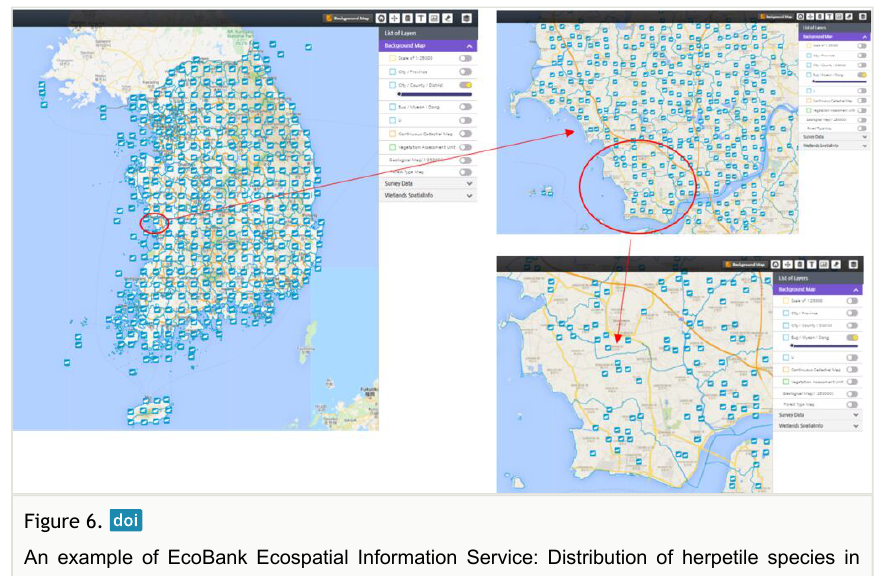
An example of EcoBank Ecospatial Information Service: Distribution of herpetile species in Korea visualised at multiple scales.